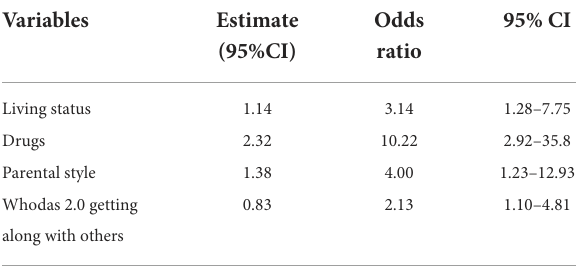
TABLE 4 Results of logistic regression. TABLE 5 Summary of the logistic